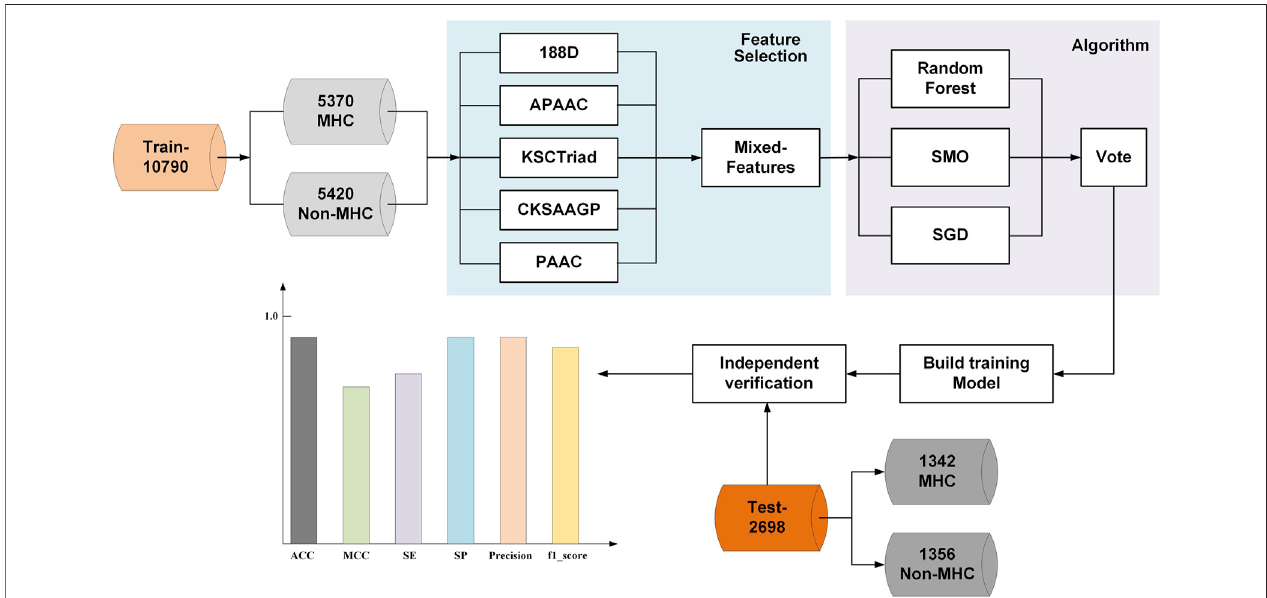
FIGURE 1 | Framework of